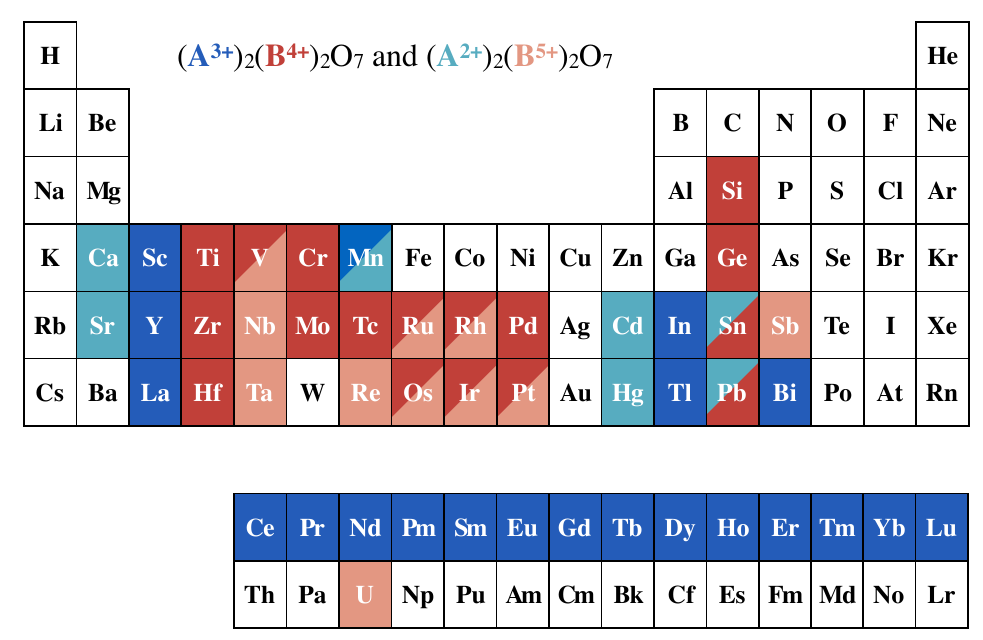
Figure 1. (color online) The periodic table with elements highlighted that can adopt the pyrochlore Figure 1.4: lattice. The colors indicate the elemental oxidation states, with 2+ in teal, 3+ in blue, 4+ in red, and 5+ in pink. Adapted from Ref.